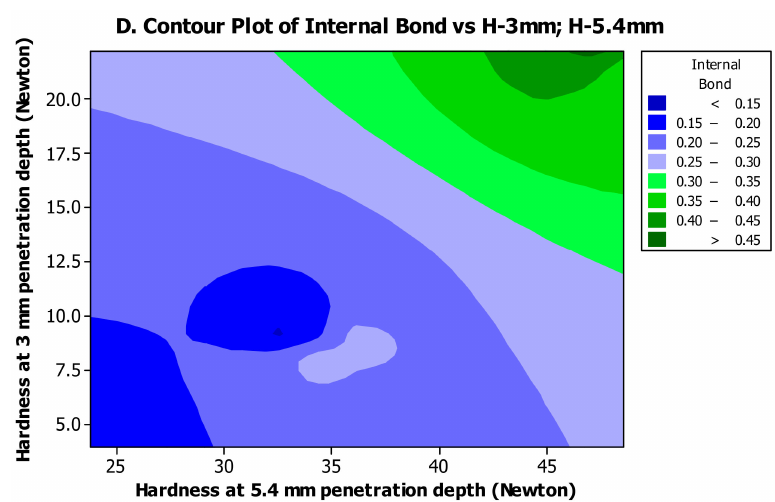
Figure 5. Contour plots among di ff erent properties of composite panels observed in this study. ( A ) among MOR and internal bond properties versus hardness at 5-mm penetration depth; ( B ) among MOR and MOE properties versus brittleness; ( C ) among brittleness and internal bond properties versus hardness at 5.4 mm penetration depth; ( D ) among hardness at 3 mm and 5.4 mm penetration depth versus internal bond. (MOR = modulus of rupture; MOE = modulus of elasticity).